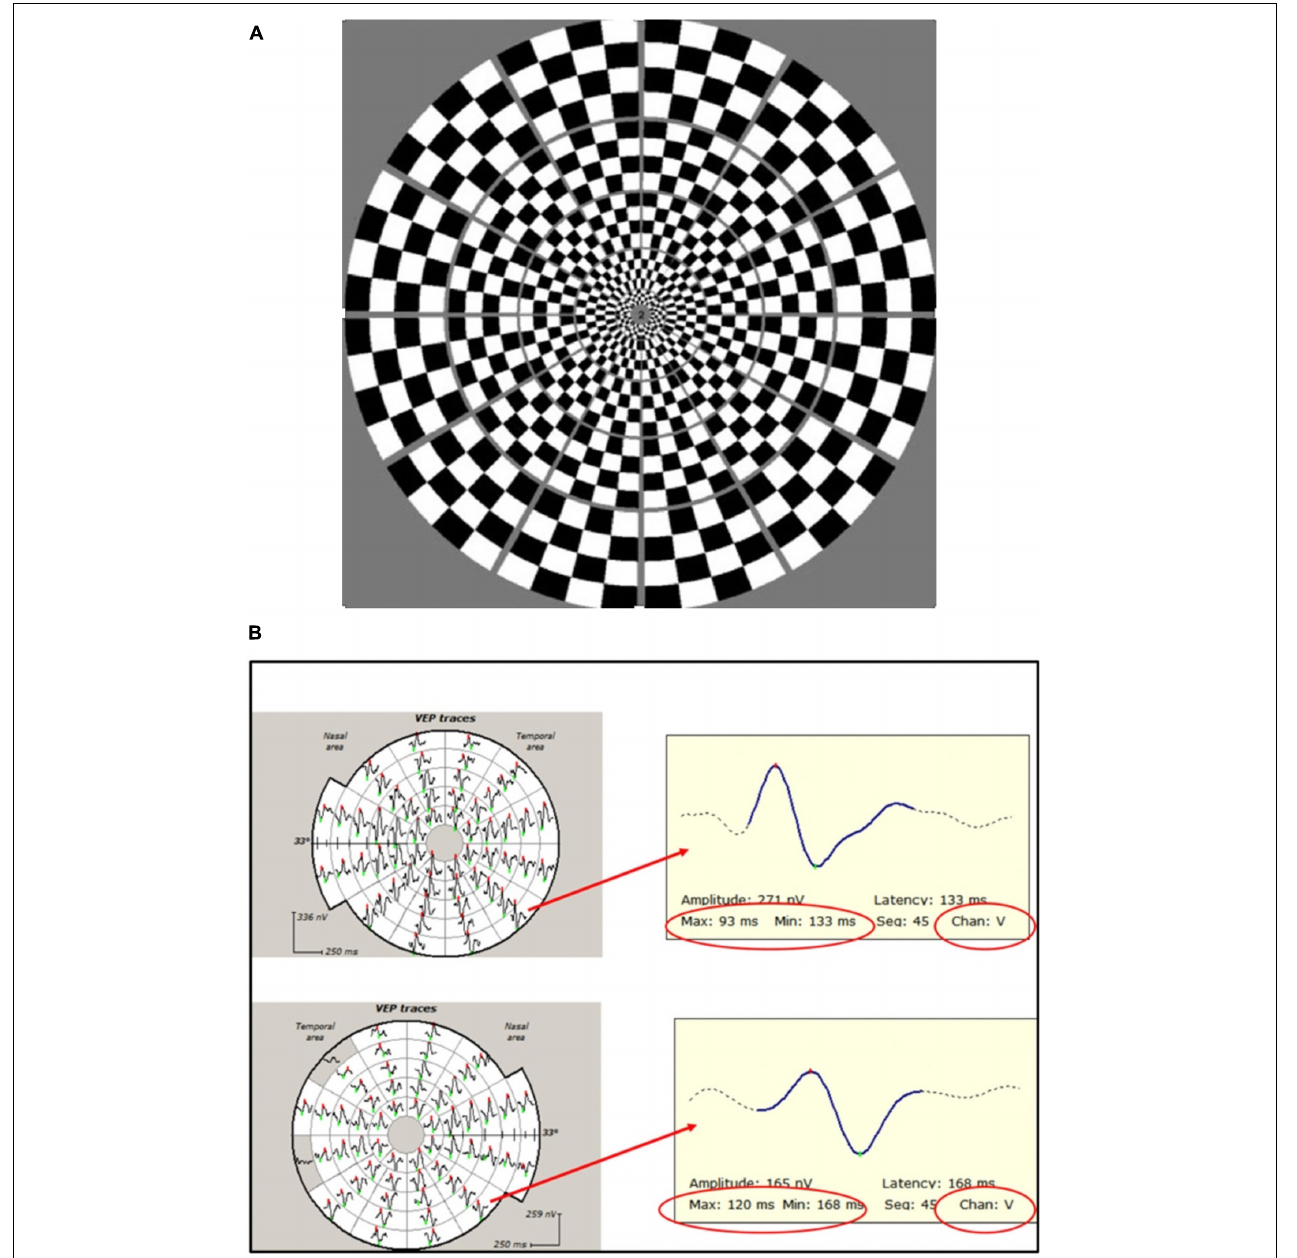
FIGURE 4 | (A) Dartboard stimulus used in mfVEP recording. (B) Example of mfVEP recording from ON (bottom row) and fellow (upper row) eyes. Individual travels from corresponding segments magnified to demonstrate latency measurement. Note that the same channel (vertical) is selected for inter-eye comparison.